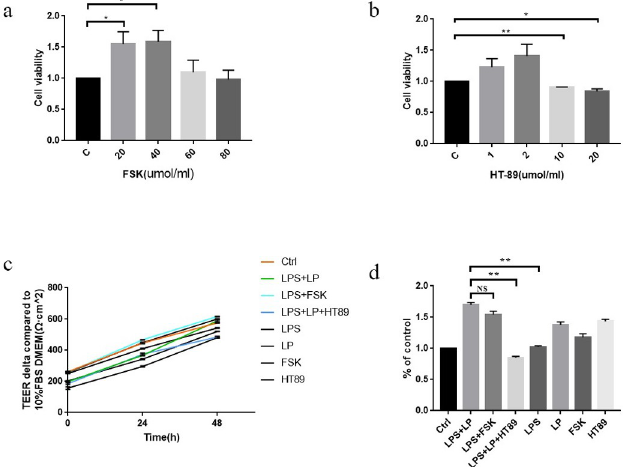
Fig 3. FSK toxicity on cells at different concentrations (a) in the experiment. Data are presented as the mean ± SD. five independent experiments were performed in duplicate. � P < 0.05 vs. control group. Toxicity of different concentrations of HT89 (b) on cells. Data are presented as the mean ± SD. three independent experiments were performed in duplicate. � P < 0.05 vs. control group, �� P < 0.01 vs. control group. (c)-(d) TEER changes in each group at 0, 24, 48, and 24–48 h. Data are presented as the mean ± SD. three independent experiments were performed in duplicate. �� P < 0.01 vs. control group or LPS + LP + HT89 group vs. LPS + LP